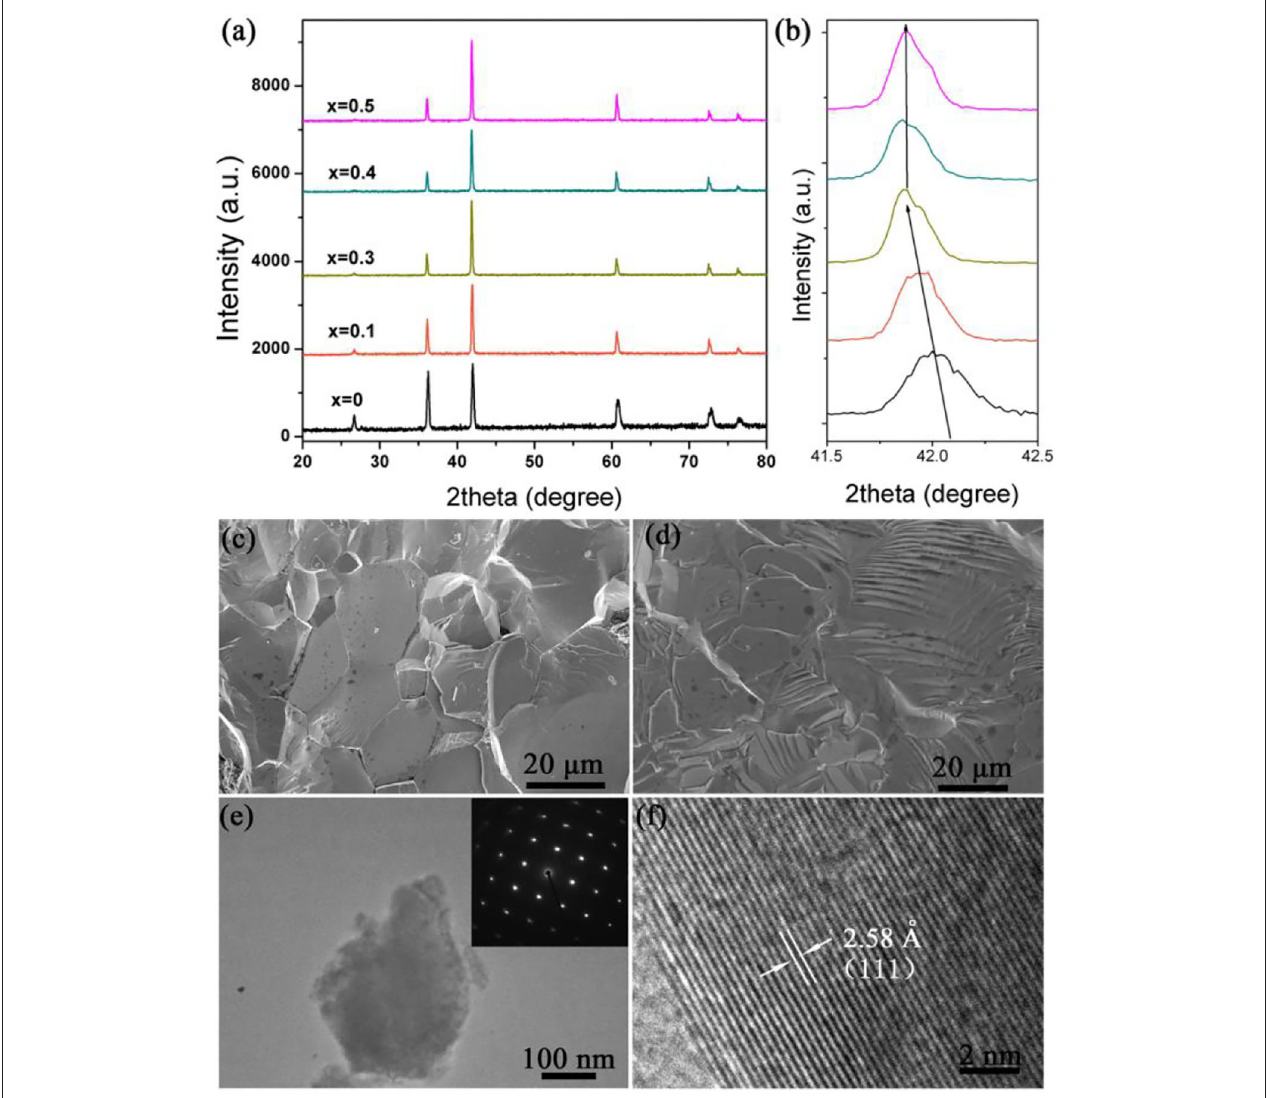
FIGURE 1 | (a) X-ray powder diffraction profiles of TiC 1 − x specimens ( x = 0, 0.1, 0.2, 0.3, 0.4, 0.5) synthesized at 2,000K, 5.0 GPa, 15min. (b) Enlarged X-ray diffraction peak position of (200) plane with decreasing carbon content. (c,d) Typical field scanning electron microscope (SEM) photographs of TiC 0.7 at different regions. (e) Bright field images of the synthesized specimen. The selected electron area diffraction patterns are given in the inset. (f) High-resolution TEM image of the obtained